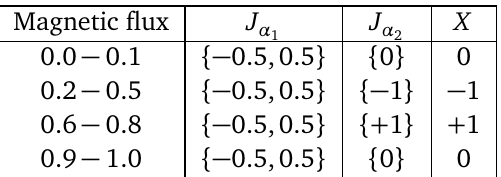
Table 2: Alternative spin quantum number configurations with the flux for N with SU(3) spin with M